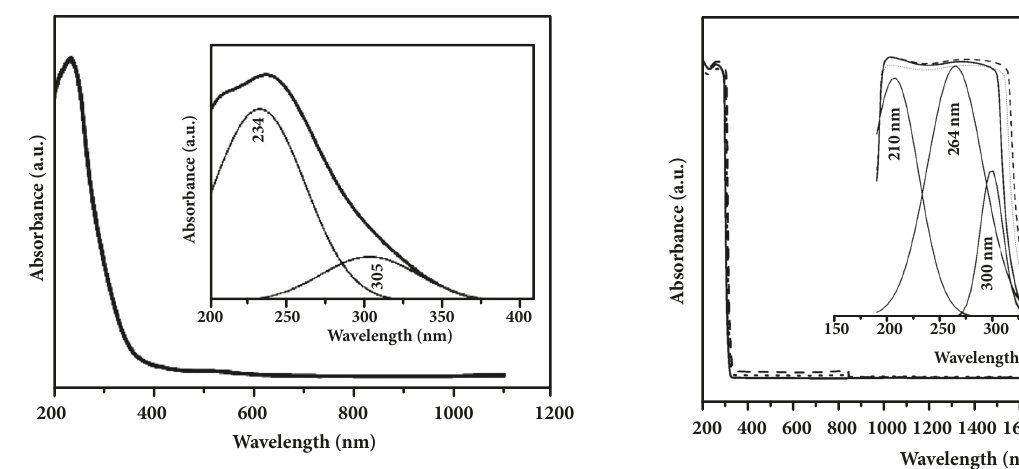
Figure 1: Optical absorption spectrum of base undoped Na 2 O − ZnO–P 2 O 5 glass with the deconvoluted spectrum of the UV region 200–400nm.